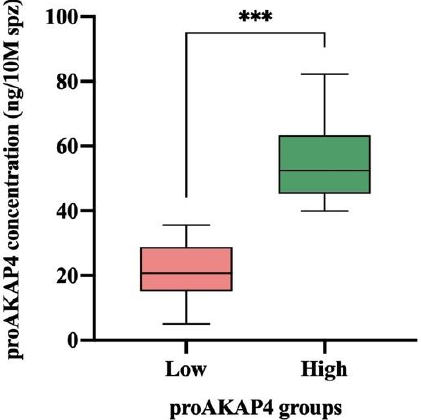
Figure 1. Box – whisker plot showing the proAKAP4 concentration (ng/10M spz) of frozen – thawed horse ejaculates as having low (n = 23; red) or high (n = 25; green) proAKAP4 concentrations. The line indicates the median, the boxes enclose the 25th and 75th percentiles, and the whiskers extend to the 5% and 95% percentiles (*** p ≤ 0.001).